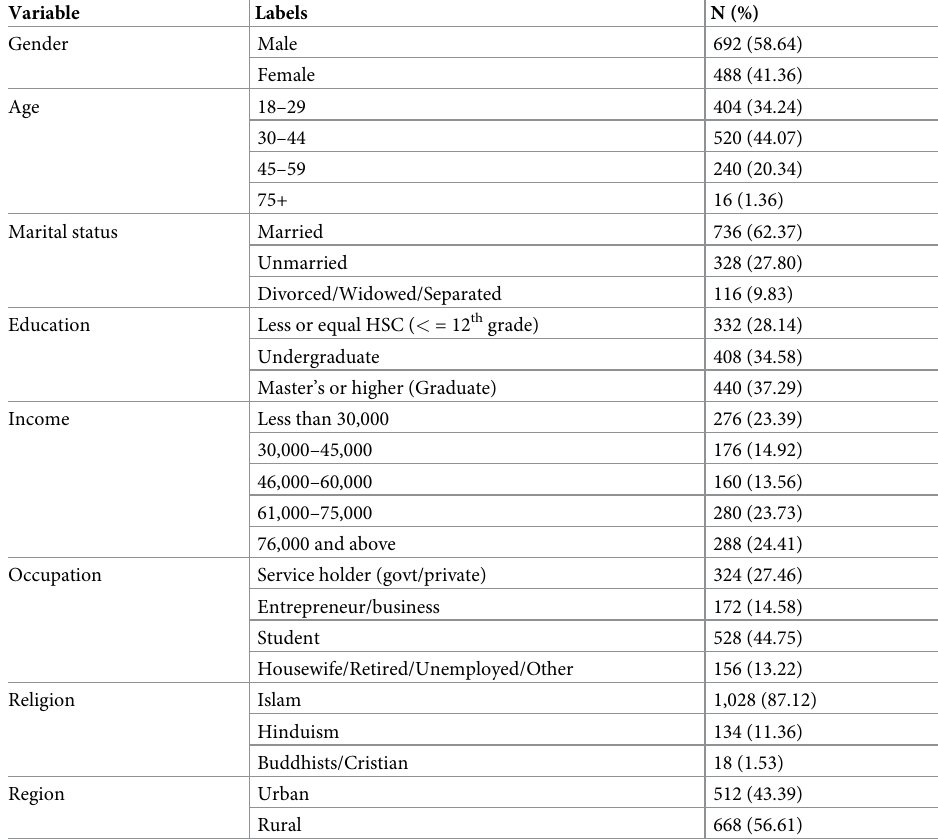
Table 1. Distribution of socio-demographic characteristics of respondents.